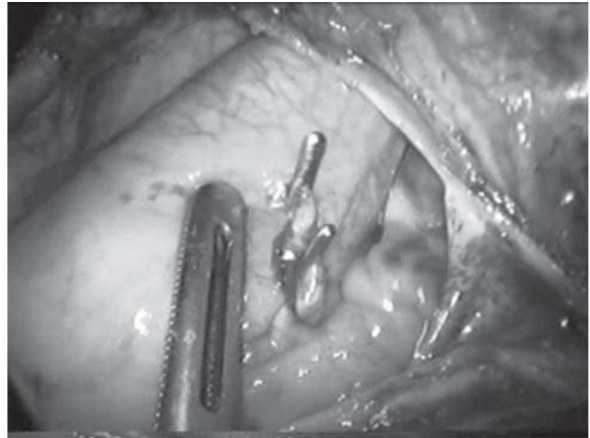
Fig. 1 - Visão panorâmica da fistula coronário-pulmonar com os clipes metálicos, sobre a artéria pulmonar